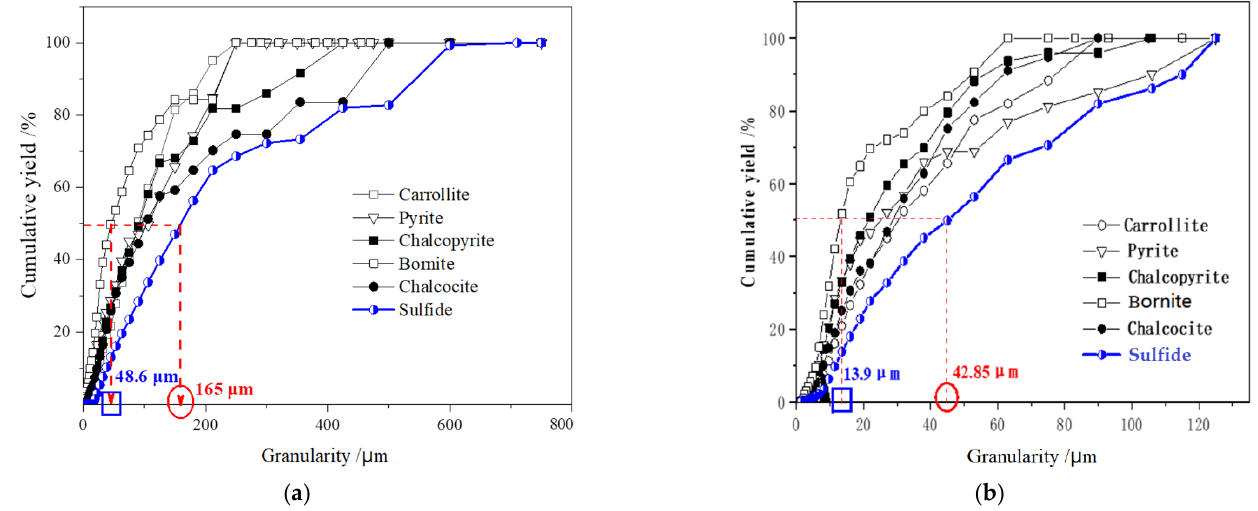
Figure 5. The granularity dissemination of most of the sulfide minerals and aggregates. ( a ) − 0.074 mm (65%); ( b ) − 0.074 mm (85.64%).